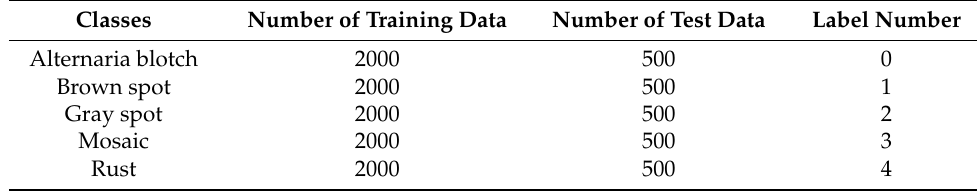
Table 1. Details of the apple leaf diseases dataset.